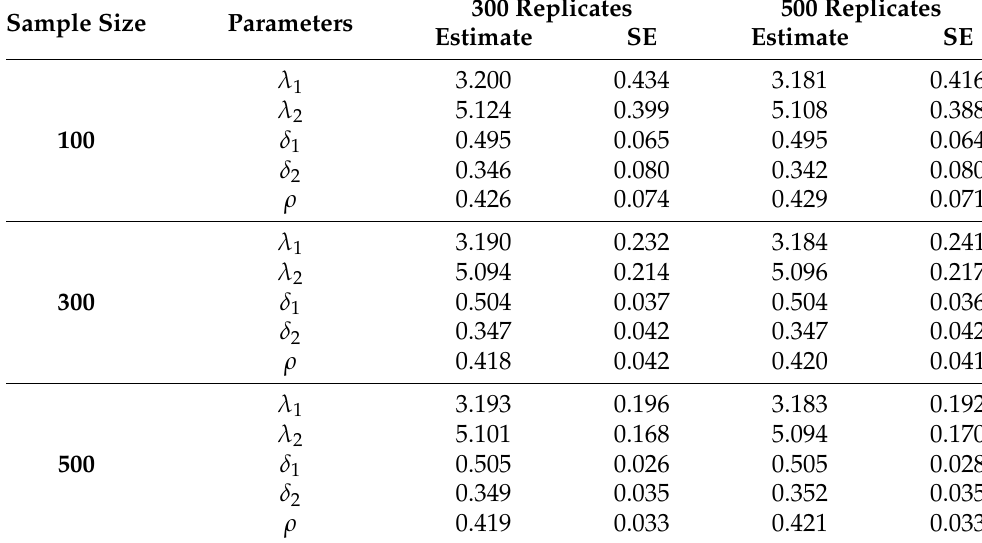
Table 3. Parameter estimates using the Gaussian copula for univariate distributions and the t-copula for the joint distribution for 300 and 500